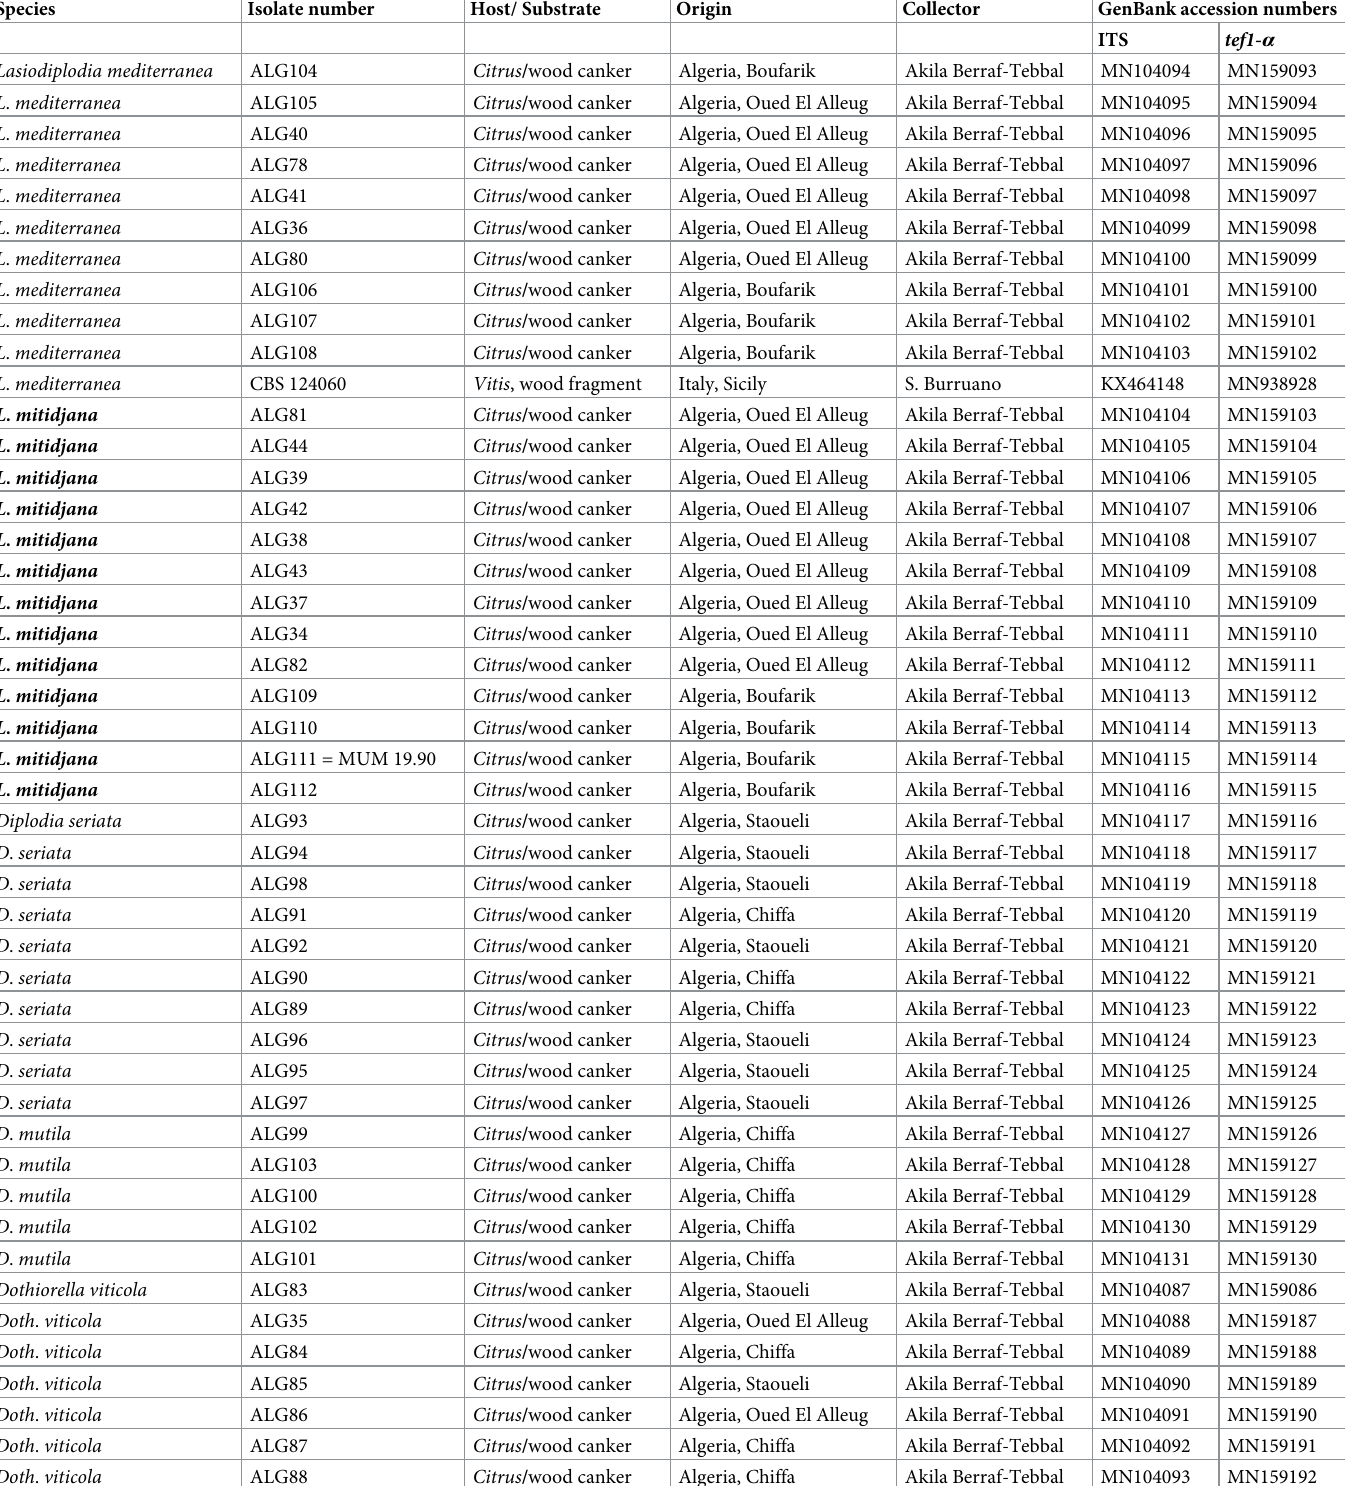
Table 2. Botryosphaeriaceae species included in this